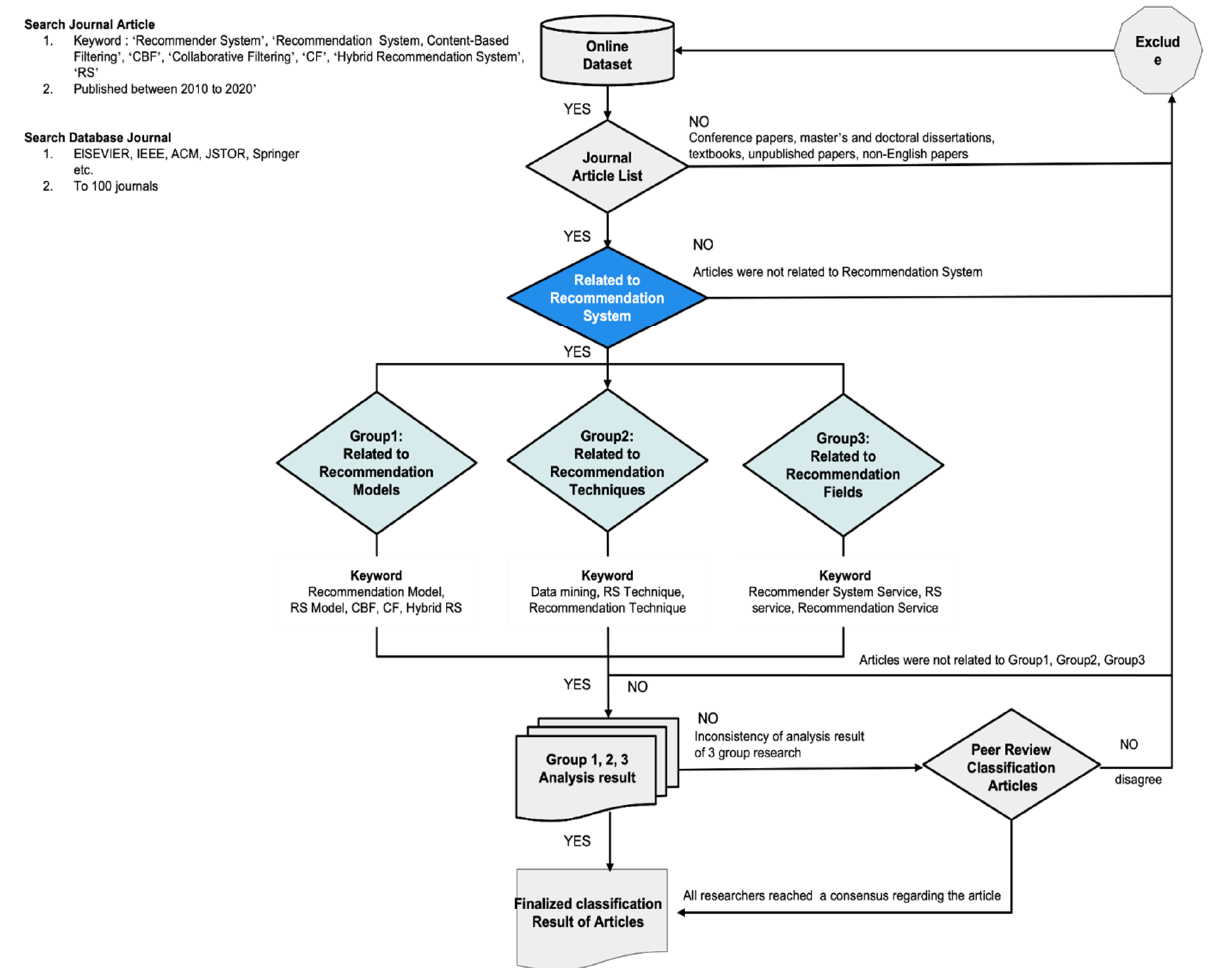
Figure 1. Process of selecting various recommendation system-related studies that were carried out for research on recommendation model, recommendation technique, trend, and recommendation service area.